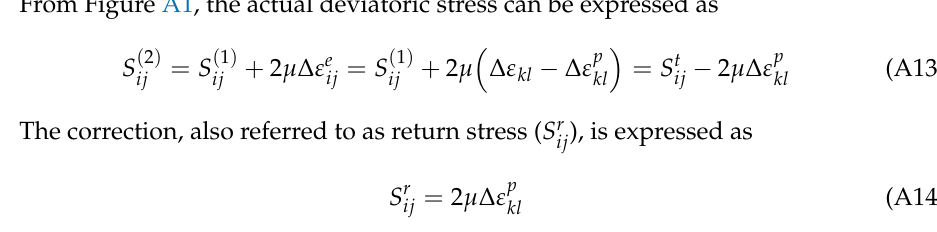
Figure A1. The radial return method for isotropic/von Mises hardening.